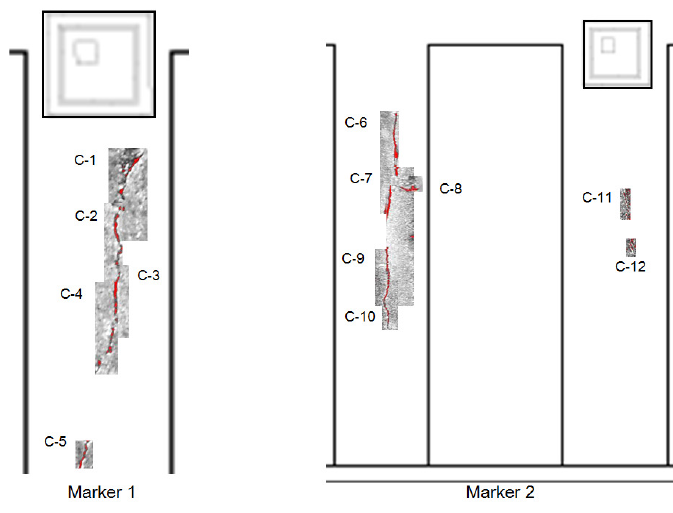
Figure 10. Bridge inspection